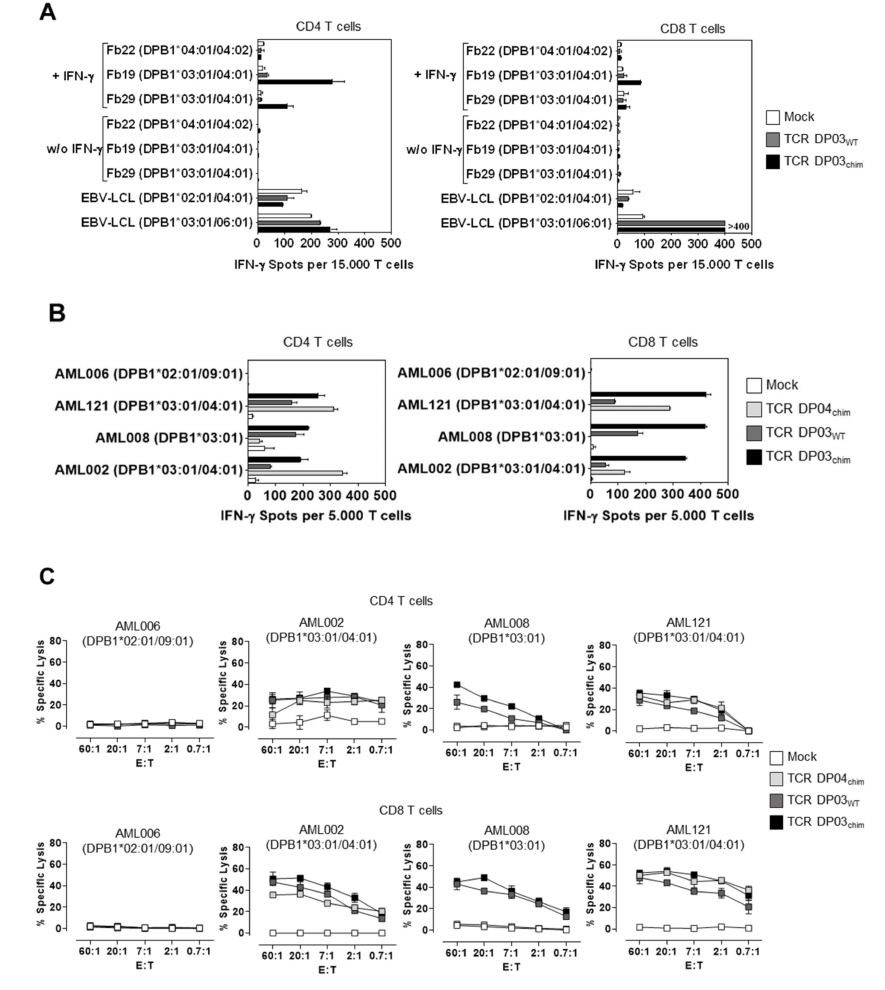
Figure 4. Reactivity of TCR DP03 against primary fibroblasts and AML blasts. ( A ) Pre-stimulated human CD4 (left panel) and CD8 T cells (right panel) from an HLA-DPB1*03:01 negative healthy donor were transfected with TCR DP03 WT or TCR DP03 chim coding RNA or without RNA (Mock). T cells were incubated with untreated or IFN- γ pretreated fibroblasts from HLA-DPB1*03:01 positive and negative donors in an E: T ratio of 0.3:1 to analyze IFN- γ spot production in ELISpot assay. EBV-LCL from HLA-DPB1*03:01 positive and negative donors served as positive and negative controls.